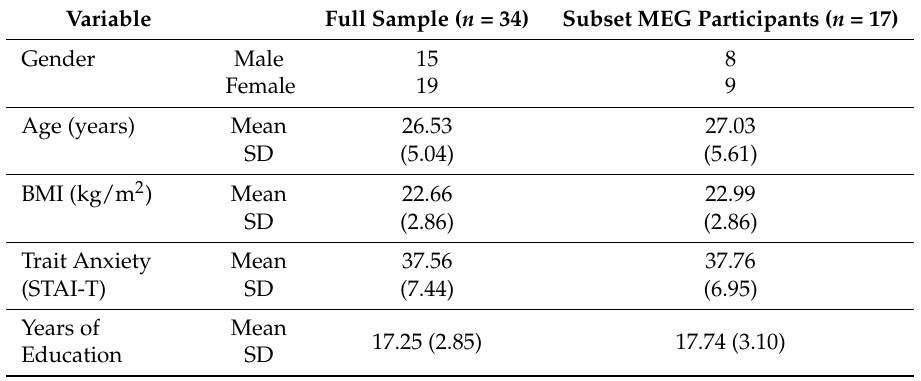
Table 1. Demographic information for study